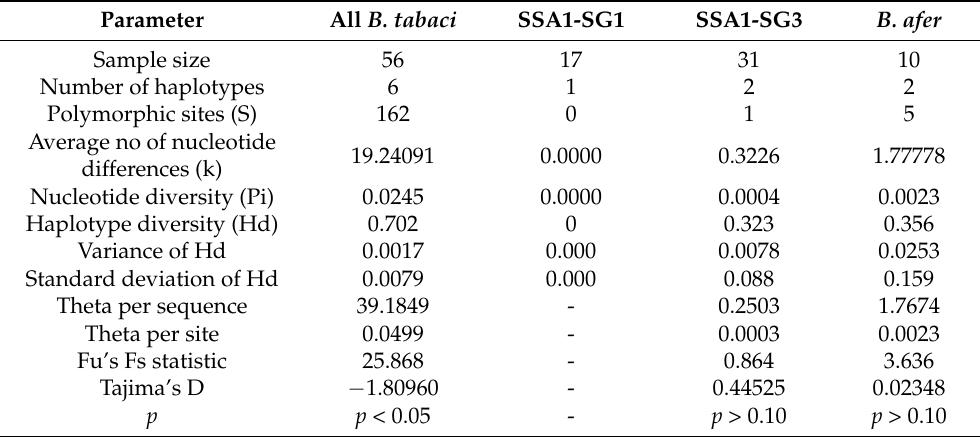
Table 1. Population genetic analysis of whitefly species Bemisia tabaci and B. afer found colonizing cassava in Kenya. Parameter All B. tabaci SSA1-SG1 Sample